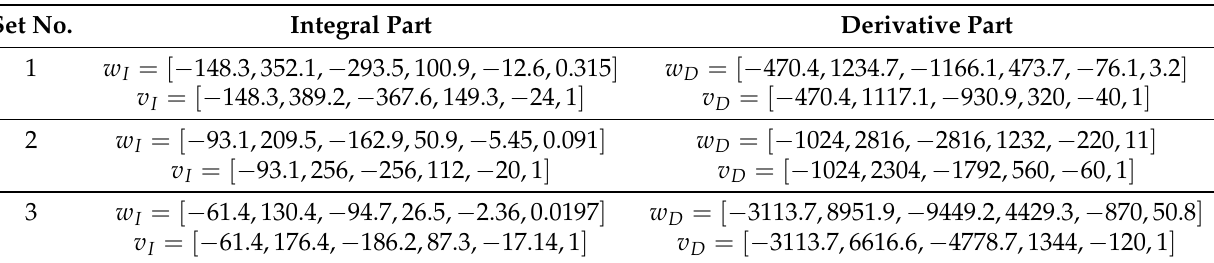
Table 4. Parameters of CFE approximation.